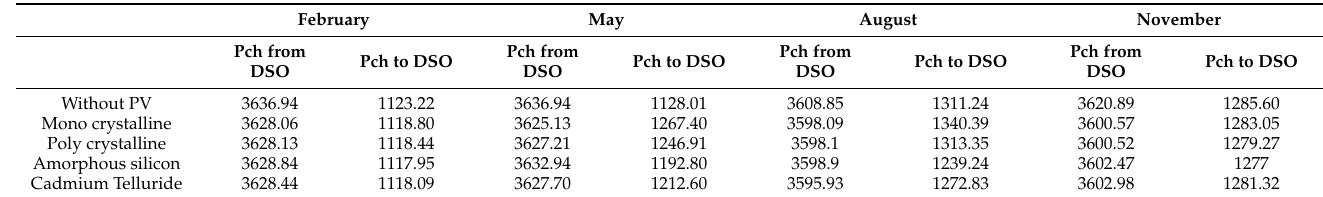
Table 6. Energy exchange between PL and DSO